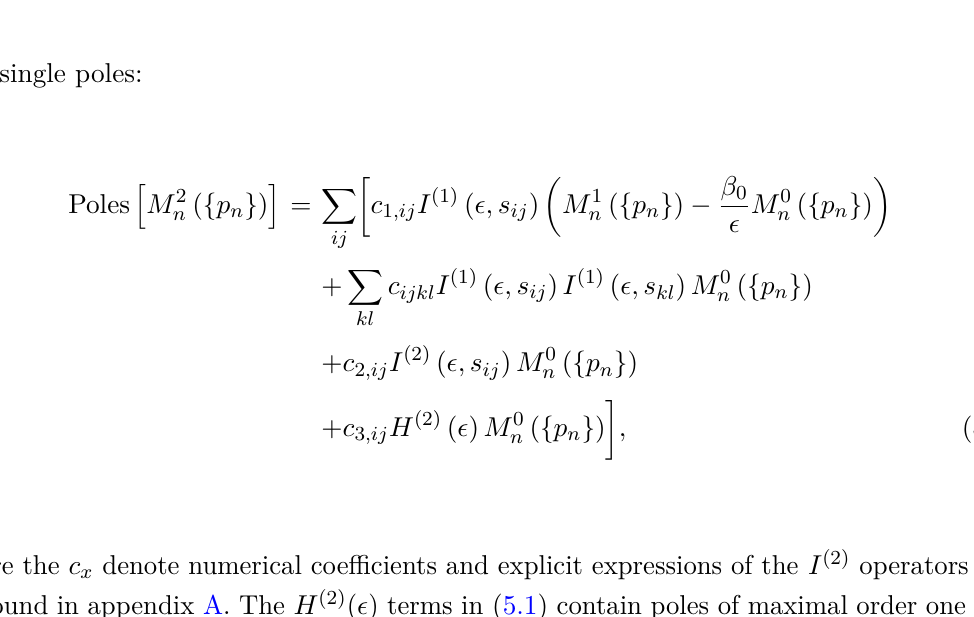
Figure 2 . Spike plots of the ratio d σ RV / d σ T verifying the correct behaviour of the subtraction in the single soft gluon (left) and single collinear q k g (right) terms for ˜ B 1 3